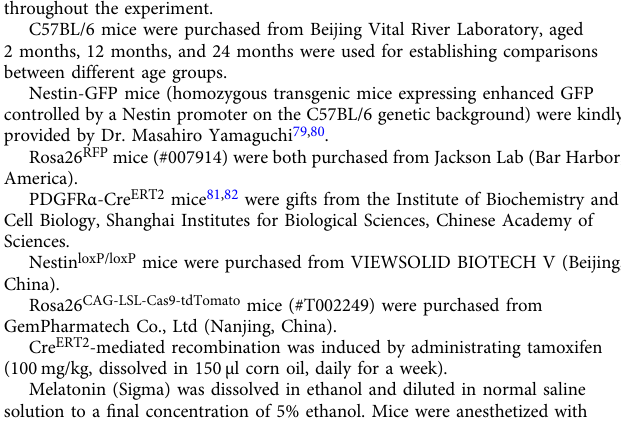
Supplementary Table 1. Two versions of adeno-associated virus vector serotype 8 expressing spgRNA under the control of the human CMV promoter were purchased from the Vigene Biosciences Co., Ltd (Shanghai, China). Mice were deeply anesthetized and intra-testis administered with 8 × 10 10 GC of a pseudotyped AAV8-spgRNA-GFP vector or 8 × 10 10 GC of a pseudotyped AAV6-spgRNA- Nestin vector. All the animals were provided free access to food and water and kept in a colony room under conditions of constant temperature (25 °C), humidity (70%), and lighting (12 h light/12 h dark cycle) in the Sun Yat-sen University Animal